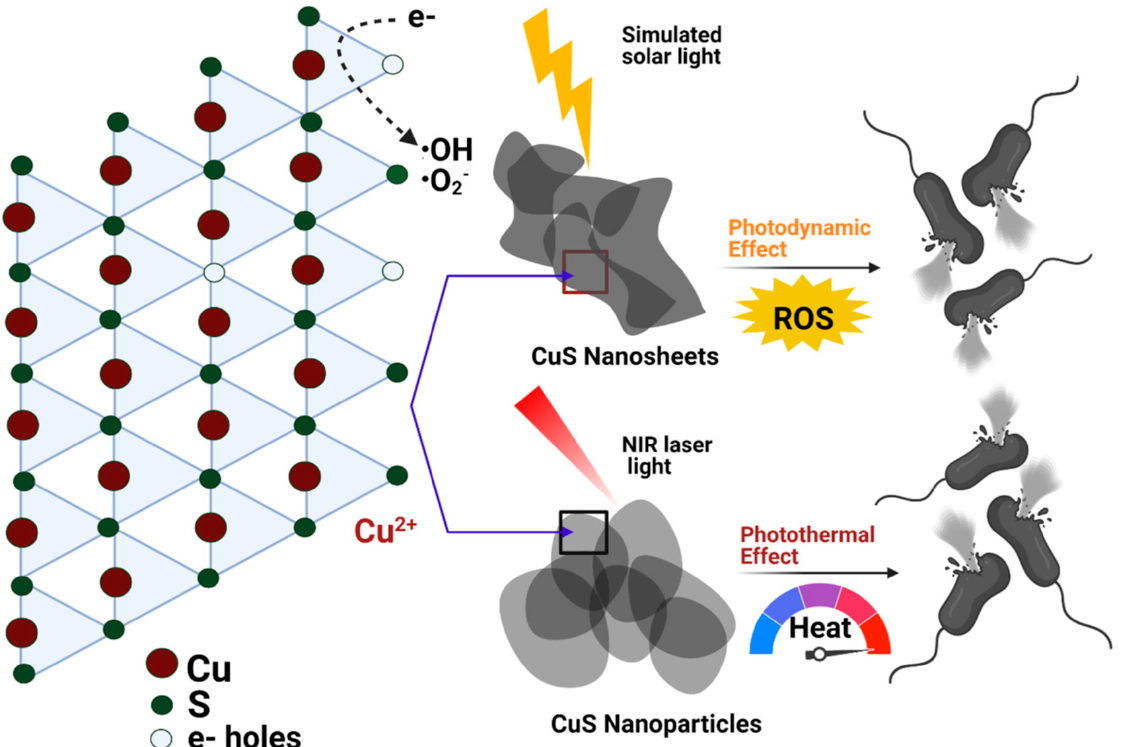
Figure 2. Schematic illustration of CuS NSs and NPs mediated photodynamic and photothermal antibacterial pathways. Reproduced with permission from Ref. [7]. Copyright 2022 Elsevier.